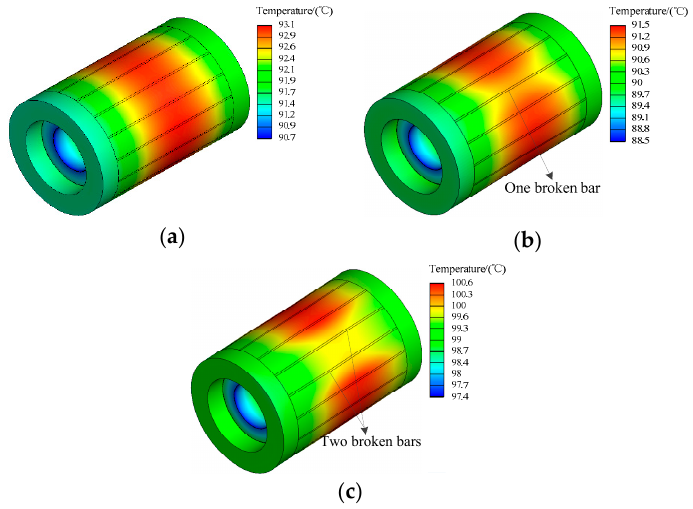
Figure 19. Temperature distribution of the rotor: ( a ) Healthy motor cage; ( b ) One-broken-bar fault; ( c ) Continuous